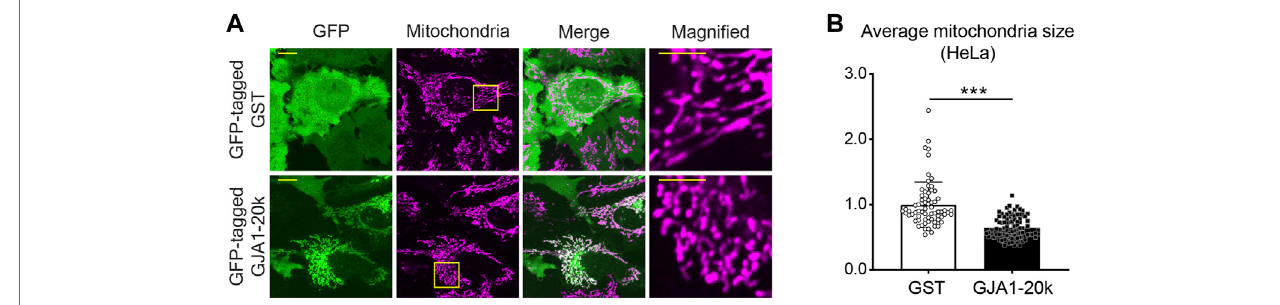
FIGURE 2 | GJA1-20k locates at mitochondria and induces mitochondrial fi ssion. (A) The representative live-cell images of GFP-tagged GJA1-20k (or GST as control) transfected HeLa cells. Mitochondria are visualized by mitotracker. The panels on the right indicate magni fi ed images. Scale bars, 10 μ m and 5 μ m in magni fi ed images. (B) The quanti fi ed fold change in the average mitochondria size with or without exogenous GJA1-20k. n = 68 (GST) or 89 (GJA1-20k) cells. Graphs are expressed as mean ± SD. p value is determined by two-tailed Mann-Whitney U -test. *** p <